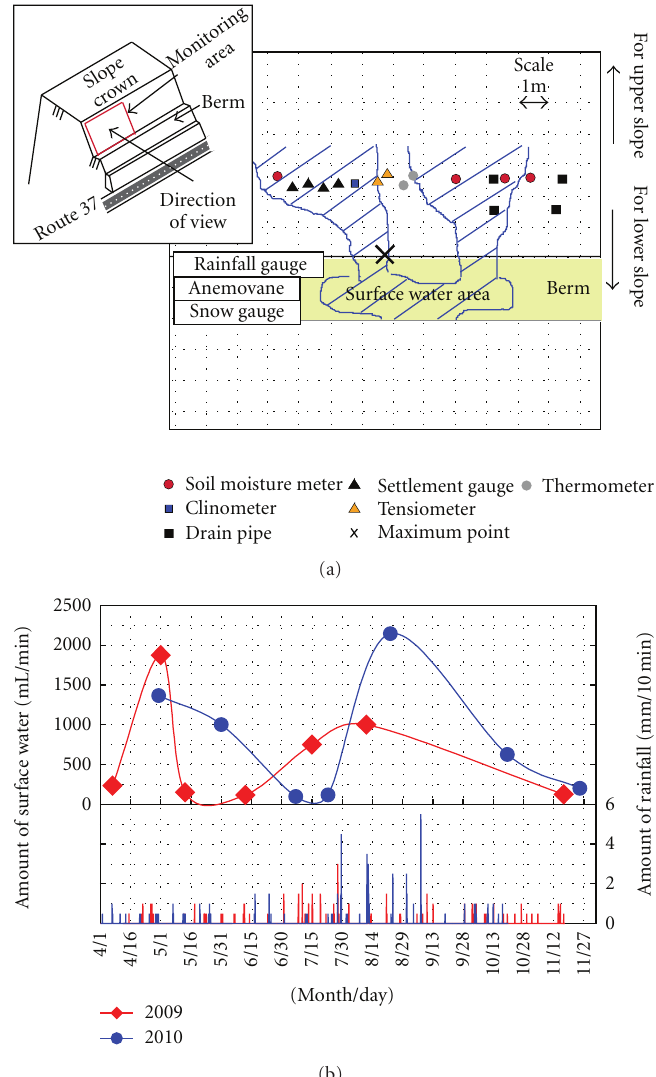
Figure 6: Change in amount of surface water at the maximum point during monitoring; (a) the maximum point at plane section and (b) relationship between the amount of surface water and